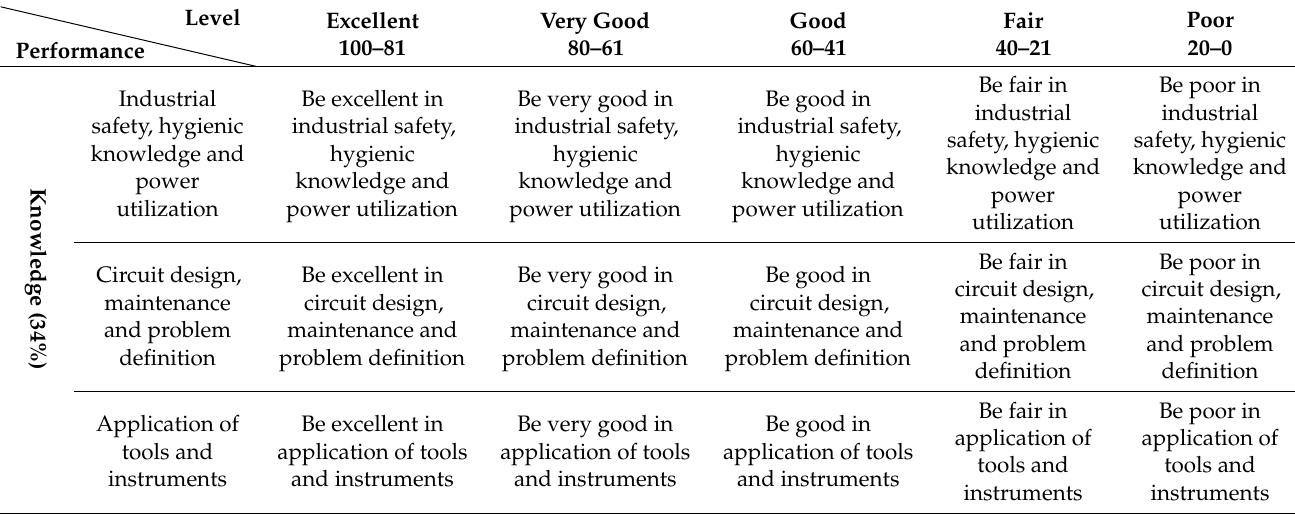
Table 2. Evaluation rubric scale developed in this research.